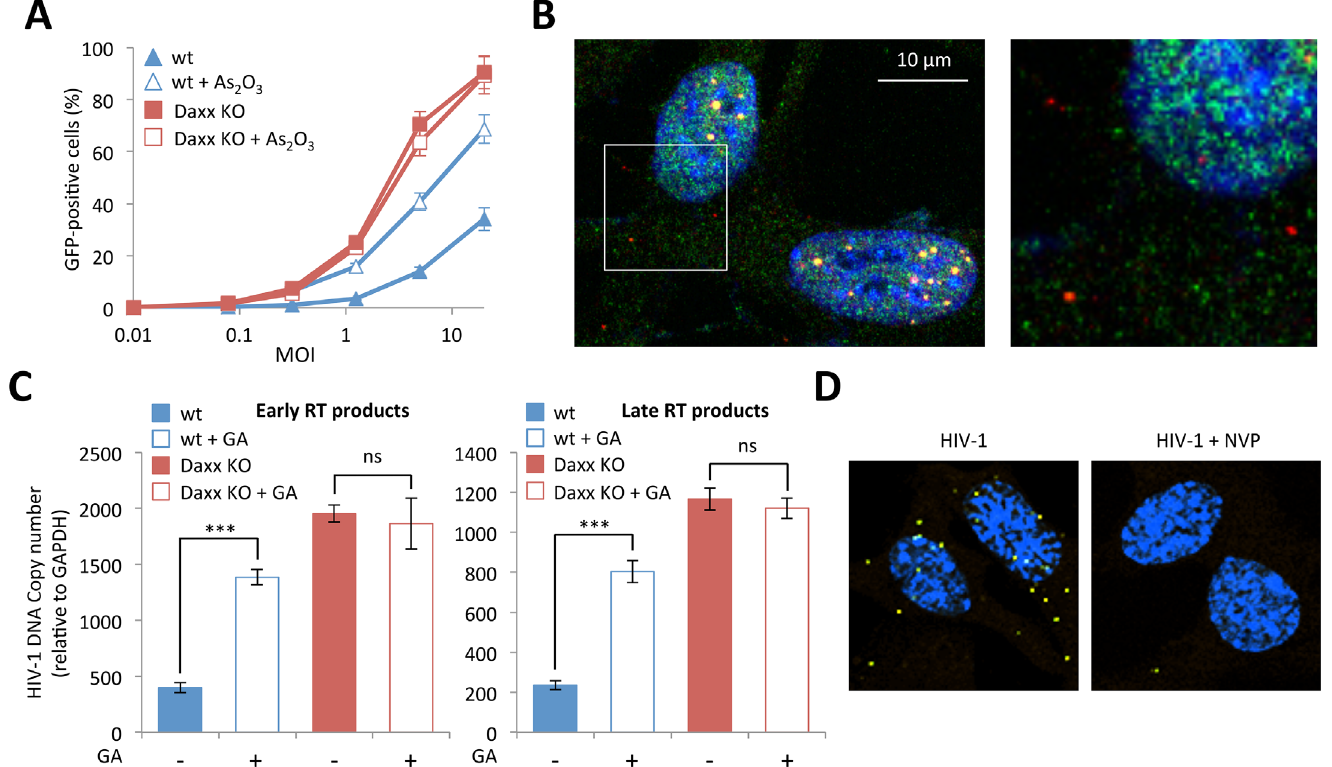
Fig 7. (A) Wt or Daxx KO MEFs were treated with 2.5 μ M of As 2 O 3 during 24h and cells were infected at different MOI with HIV-1 vector during 48h. The percentage of GFP expressing cells was determined by flow cytometry. The graph shows means of duplicate values +/- SD, representative of three independent experiments. (B) Wt HeLa cells were transduced for 2 h with HIV-1 vector and PML (in red) and Daxx (in green) localization was analyzed by immunofluorescence. (C) Wt or Daxx KO MEFs were transduced with HIV-1 vector in the presence or not of 100 μ M of GA. Six hours post-transduction, early and late reverse transcripts were quantified by qPCR. Graphs show means of triplicate values +/- SD, representative of two independent experiments. Student t-test was performed to determine P values ( *** P < 0.001; ns, not significant). (D) Wt MEFs were treated or not with nevirapine (NVP), transduced with HIV-1 for 2 h and probed with anti-Daxx and anti-HIV-1 p24 antibodies. Representative images of a Duolink experiment are shown.